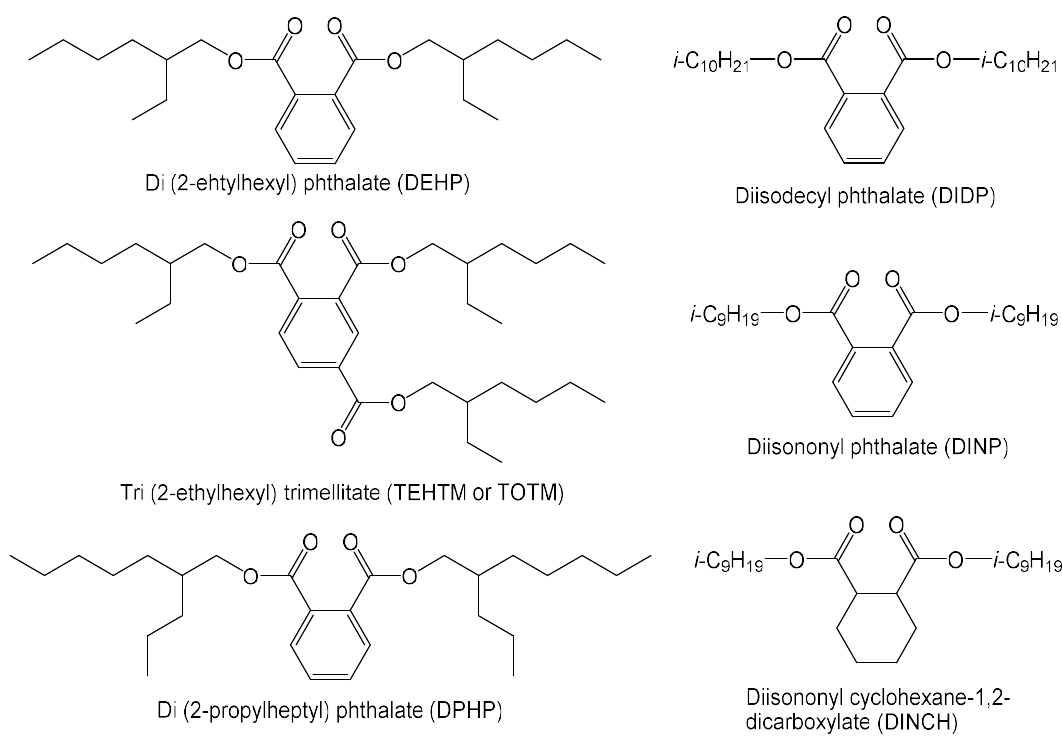
Figure 1. Chemical structures of important commercial plasticizers including four phthalates [di(2